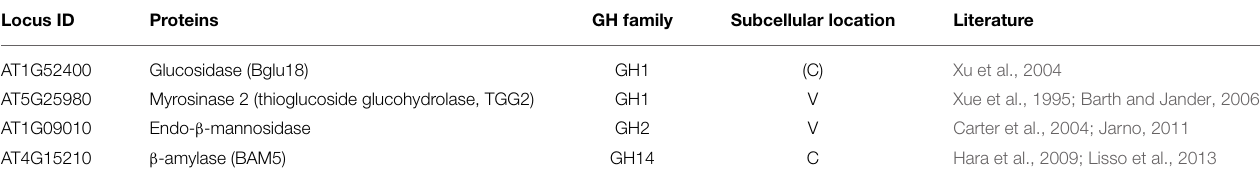
TABLE 3 | List of four identified CaCl 2 -extracted intracellular glycoside hydrolases in stems of Arabidopsis at the late growth stage. Locus